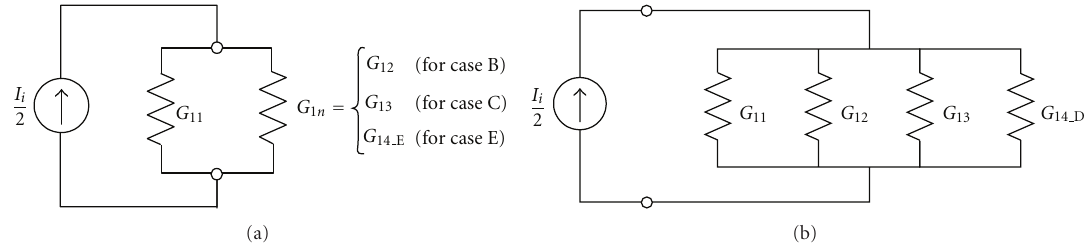
Figure 5: Equivalent circuit representation for (a) cases B, C, and E and (b) case D.